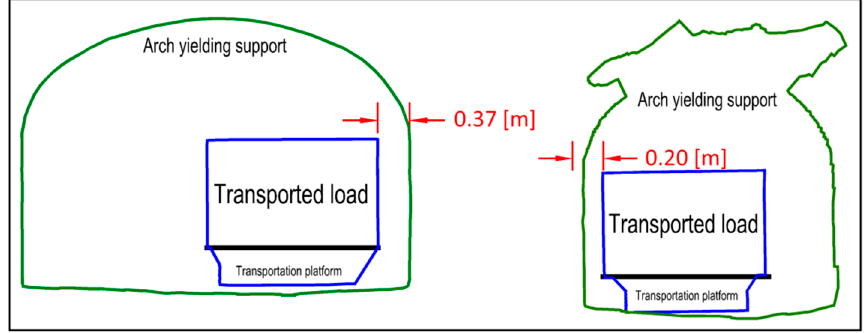
Figure 16. Cross-sections of selected area of the underground working.